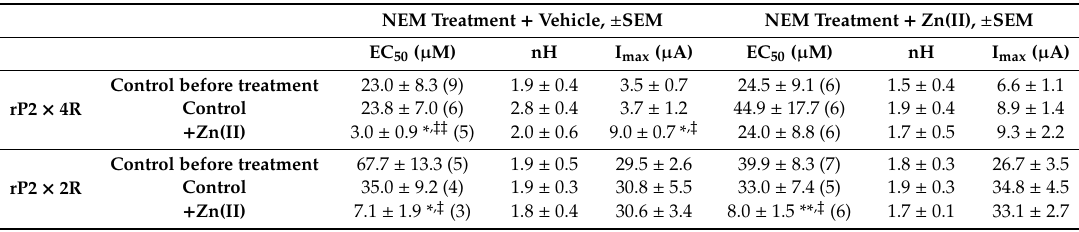
Table 1. Pharmacological characterization of the wild type rP2 × 4R and rP2 × 2 before and after NEM or NEM + Zn(II)